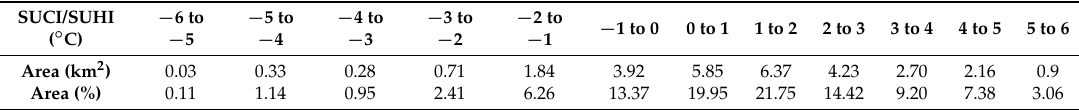
Figure 7. Area occupied by the average SUHIs and SUCIs. Table 3. Area occupied by the classes of average SUHIs and SUCIs in the Ceres and Rialma cities and